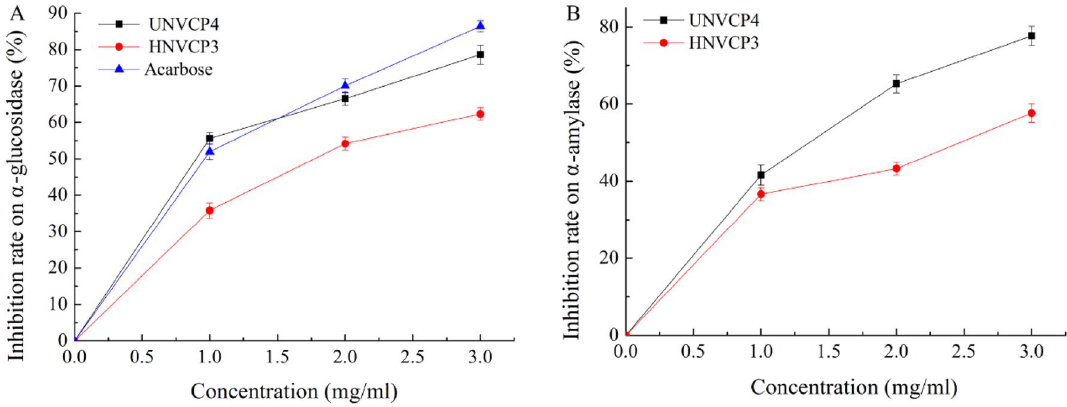
Figure 6. Inhibition rates of α-amylase and α-glucosidase by HNCP3 and